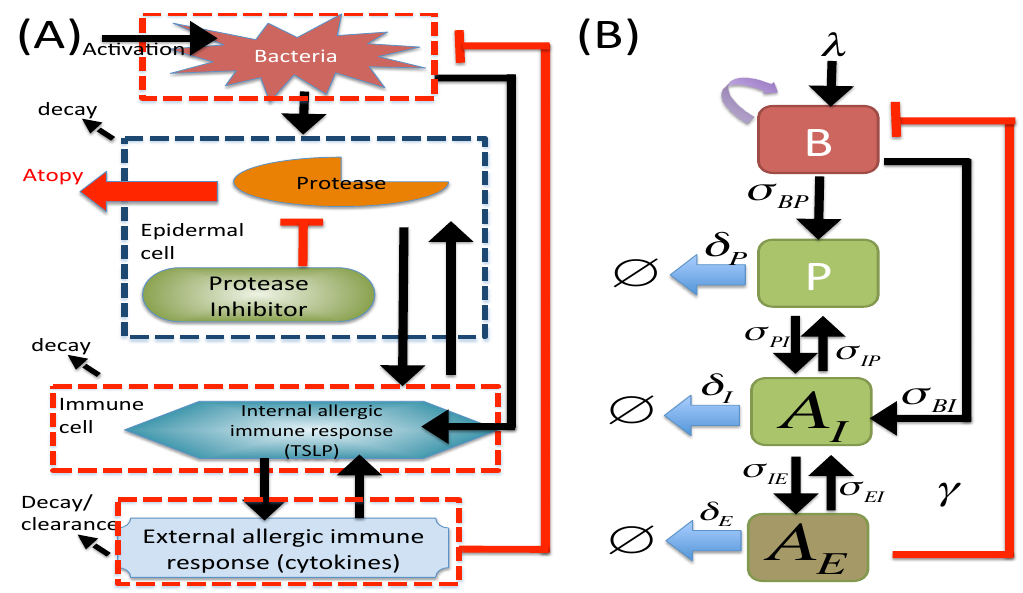
Figure 1. A schematic of the M1 model. ( A ) A schematic of immune responses to bacterial infection; ( B ) the final network model that abstracts the key structure of the interaction network in (A). By merging a multi-species compartment (blue dashed box in (A) including proteases and their inhibitors) into a compartment (‘ P ’ in (B)), we get a simpler model in (B). Densities of bacteria, proteases, intracellular transcription factor and extracellular cytokines are represented by ‘ B ’, ‘ P ’, ‘ A I ’ and ‘ A E ’,